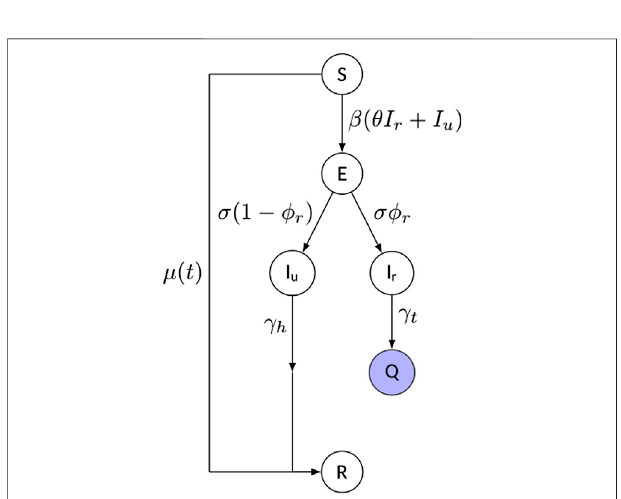
FIGURE 2 | Schematic of the model and of its parameters (see text for details). The “ quarantined ” variable Q ( t ) coincides, by construction, with the time-series of of fi cial laboratory-con fi rmed infections C ( t i ) , when evaluated at the same sample points; Q ( t ) is thus the only known variable in the context of a data-driven calibration of the